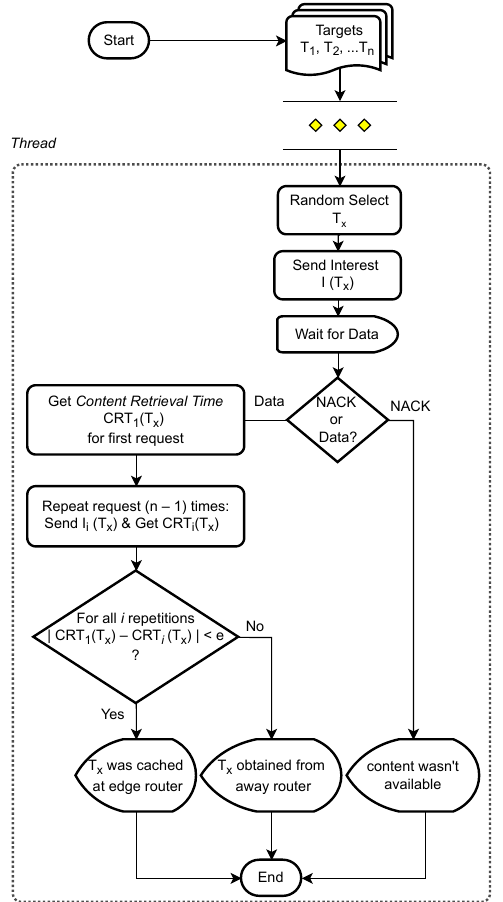
Figure 9. Attack process algorithm with the brute-force design (Adapted from